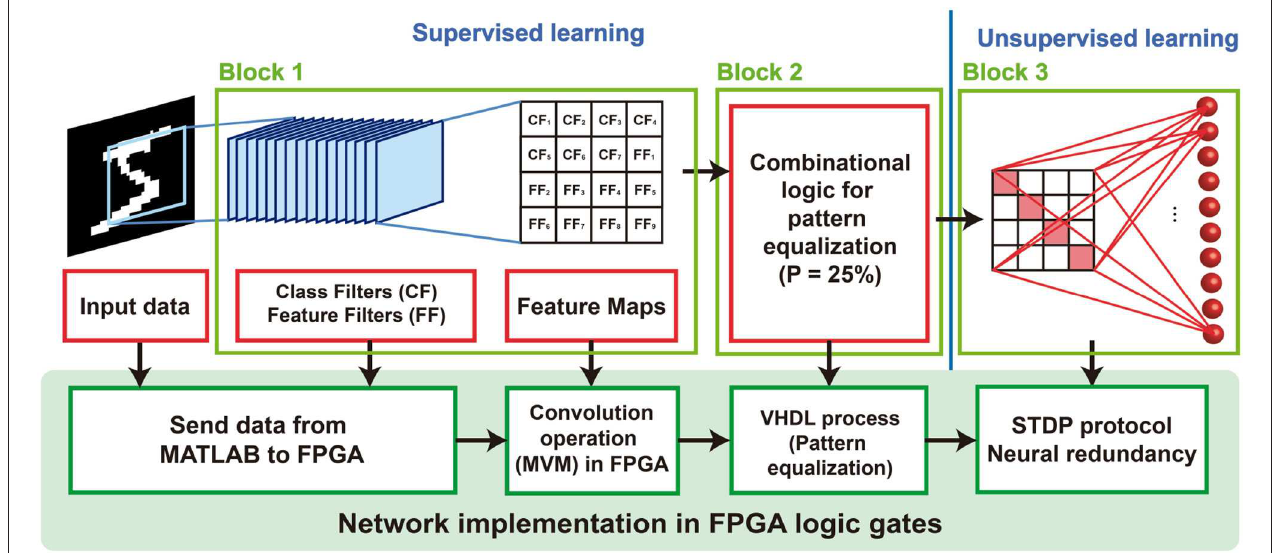
FIGURE 2 | Schematic representation of the hybrid supervised/unsupervised network for solving continual learning. Each one of the blocks have been implemented in an FPGA using logic